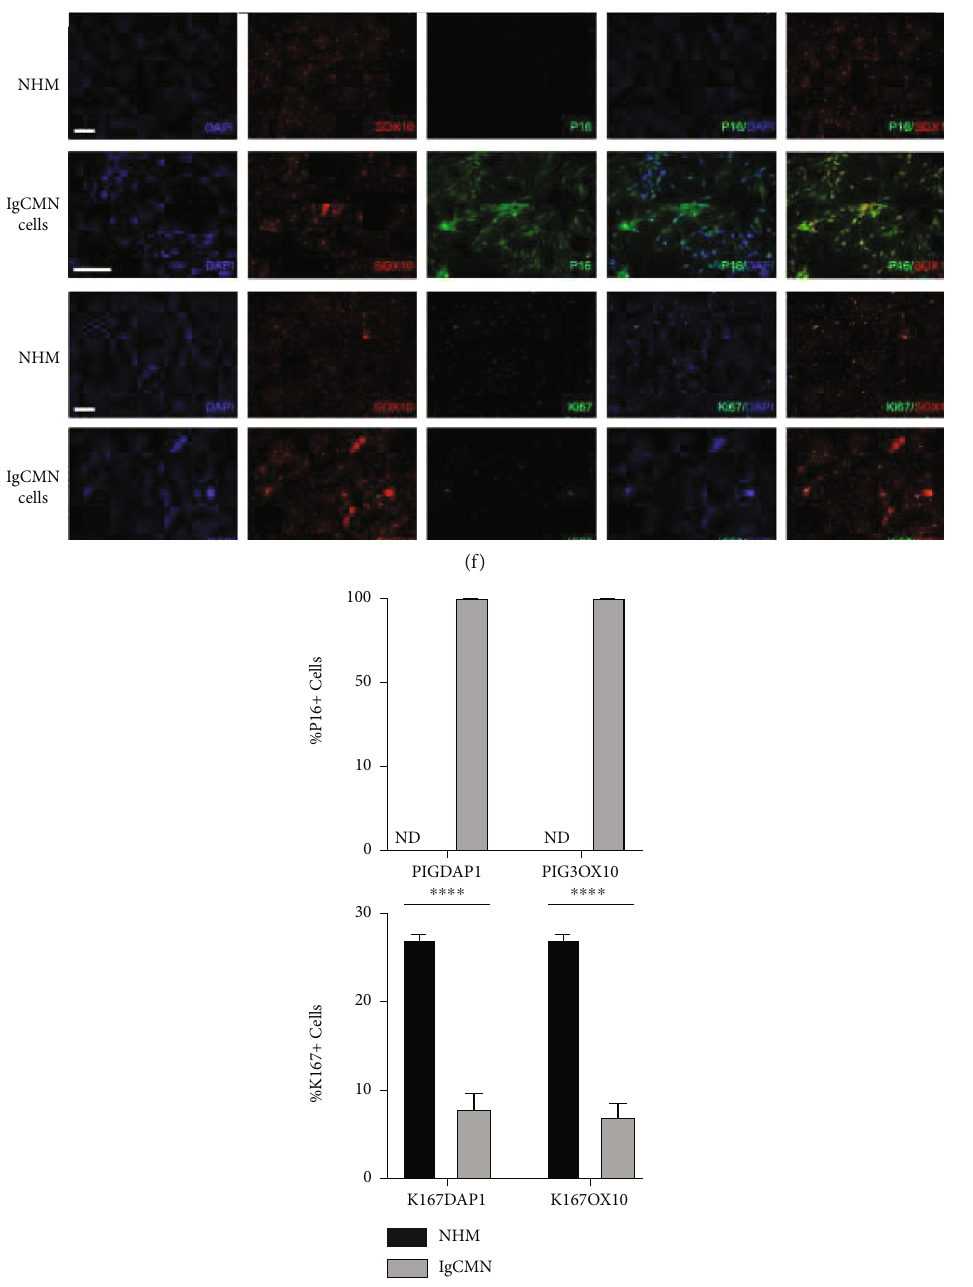
Figure 4: Cell cycle arrest and signi fi cantly upregulated P16 expression in lgCMN. (a) Relative gene expression of cell cycle inhibitors in lgCMN and normal skin tissues. Red bars represent upregulation, and blue bars represent downregulation. (b) Morphology of A375, NHM, and lgCMN cells with di ff erent shapes and number of dendrites. (c) Cell cycle assays. P2 cells of each cell line were cultured for the experiment. (d) Immunohistochemical staining for SOX10 (upper panels), P16 (middle panels), and Ki67 (lower panels) of normal skin ( n = 5 ; patient2 + patient4 + patient 5 + patient9 + patient 10 ), lgCMN ( n = 5 ; patient 2 + patient4 + patient 5 + patient9 + patient 10 ), and lgCMN-developed melanoma ( n = 1 ; a supplementary lgCMN patient with malignant transformation at 4 years of age). SOX10, P16, and Ki67 were stained using the AEC chromogen. (e) Histograms show the number of P16+ or Ki67+ cells per SOX10+ cells in the epidermis and dermis. (f) Immuno fl uorescent staining of SOX10, P16, and Ki67 in P2 NHM ( n = 3 ; patient2 + patient 9 + patient 10 ) and P2 lgCMN cells ( n = 3 ; 3 foreskin samples from di ff erent children). P16+ and Ki67+ cells were stained using FITC-conjugated antibodies, and SOX10+ cells were stained using Cy3-conjugated antibodies. (g) Histograms show the number of P16+ or Ki67+ cells per DAPI and SOX10+ cells. ∗∗∗∗ P < 0 : 0001 represents di ff erences between NHM and lgCMN in the t -test. Error bars represent the mean ± SD . lgCMN: large to giant congenital melanocytic nevus; NHM: normal human melanocytes; P2: passage 2; ND: not detected; SD: standard deviation. Scale bar = 50 μ m